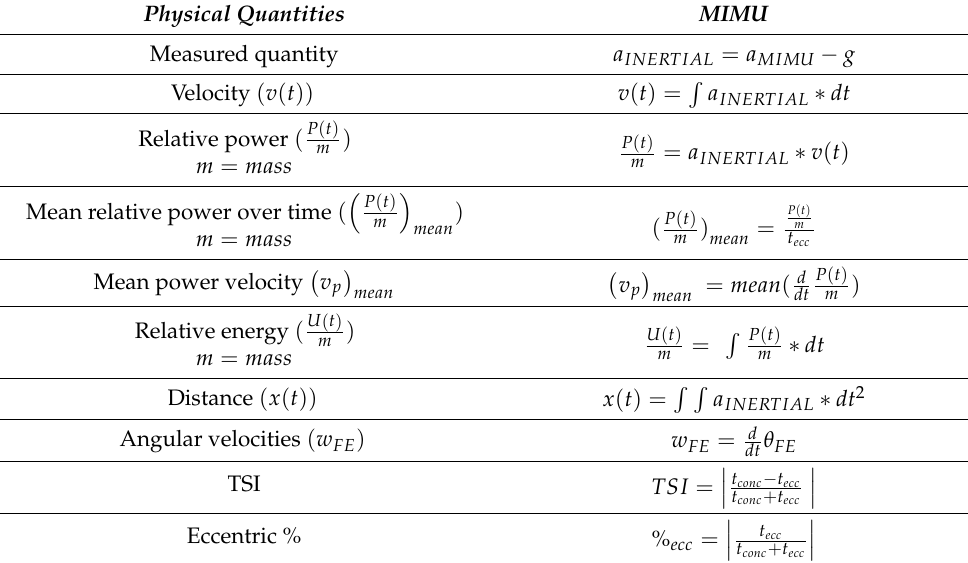
Table 1. Main formulas for parameters